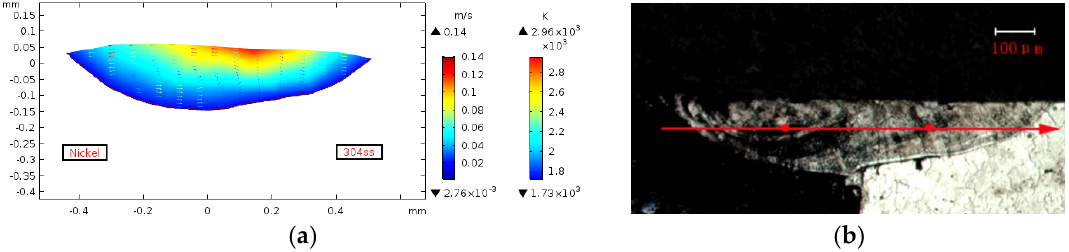
Figure 7. Comparison of calculated and experimental weld pool configurations under a heat input of 26.7 J/mm. ( a ) Calculated weld pool configuration ( b ) Experimental weld configuration. 26.7 J/mm. ( a ) Calculated weld pool configuration ( b ) Experimental weld